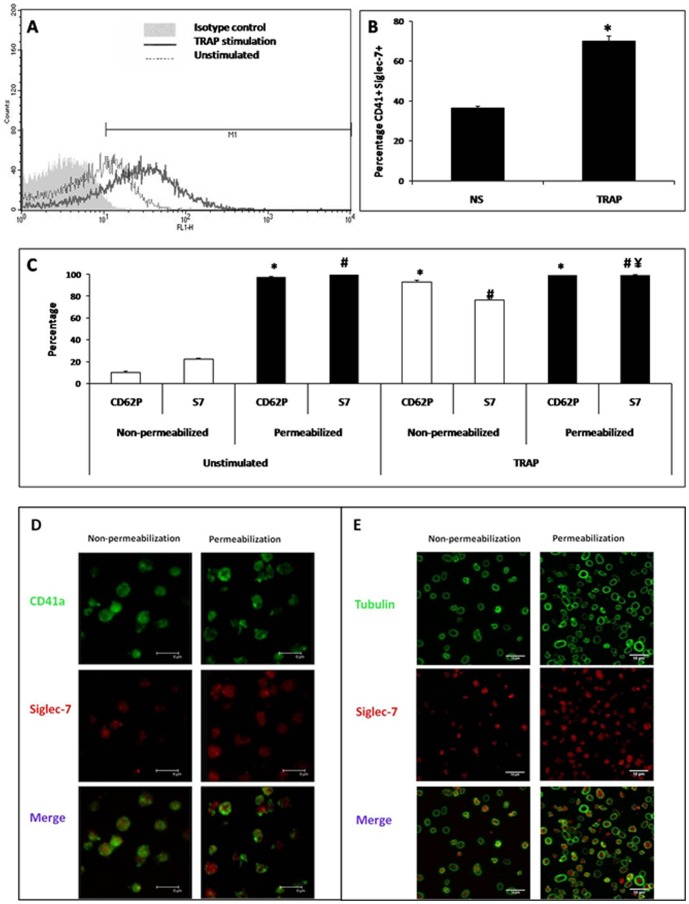
Expression of Siglec-7 in human platelets.(A), (B) Siglec-7 expression in platelets was analyzed by flow cytometry (n = 20). Platelets (stimulated with TRAP or vehicle control) were labeled with anti-CD41a and anti-Siglec-7 mAbs. Membrane expression of Siglec-7+ was increased after TRAP-induced platelet activation (*significant difference, of %CD41a+Siglec-7+ between TRAP-induced platelets activation vs resting platelets, t-test, p<0.05). (C) Membrane and intracellular localization of Siglec-7 in platelets. Platelets before and after permeabilization (stimulated with TRAP or vehicle control) were labeled with anti-CD41a, anti-CD62P (positive control for permeabilized platelets) and anti-Siglec-7 mAbs. Gating on the CD41a+ population, intra-platelet expression of Siglec-7 is significantly higher than its membrane expression (in both stimulated and unstimulated) (*, # significant difference (t-test, p<0.05) between %CD41a+CD62P+ or %CD41a+Siglec-7+, respectively, vs non-permeabilized resting platelets. (D) Distribution of Siglec-7 in platelets analyzed by confocal microscopy. Immunofluorescence labeling with anti–CD41a, and anti-Siglec-7 mAbs, and overlay (top to bottom). Siglec-7 staining in permeabilized (right panel) and non-permeabilized platelets (left panel) shows intracellular expression is more important than membrane expression. Scale bars = 6 µm. (E) Labeling with anti-tubulin and anti Siglec-7 antibodies and overlay (top to bottom). Siglec-7 is expressed on platelet membranes and tubulin is stained in permeabilized platelets. Tubulin was labeled to demarcate platelet borders and Siglec-7 is mostly observed in intracellular compartments. Scale bars = 10 µm.